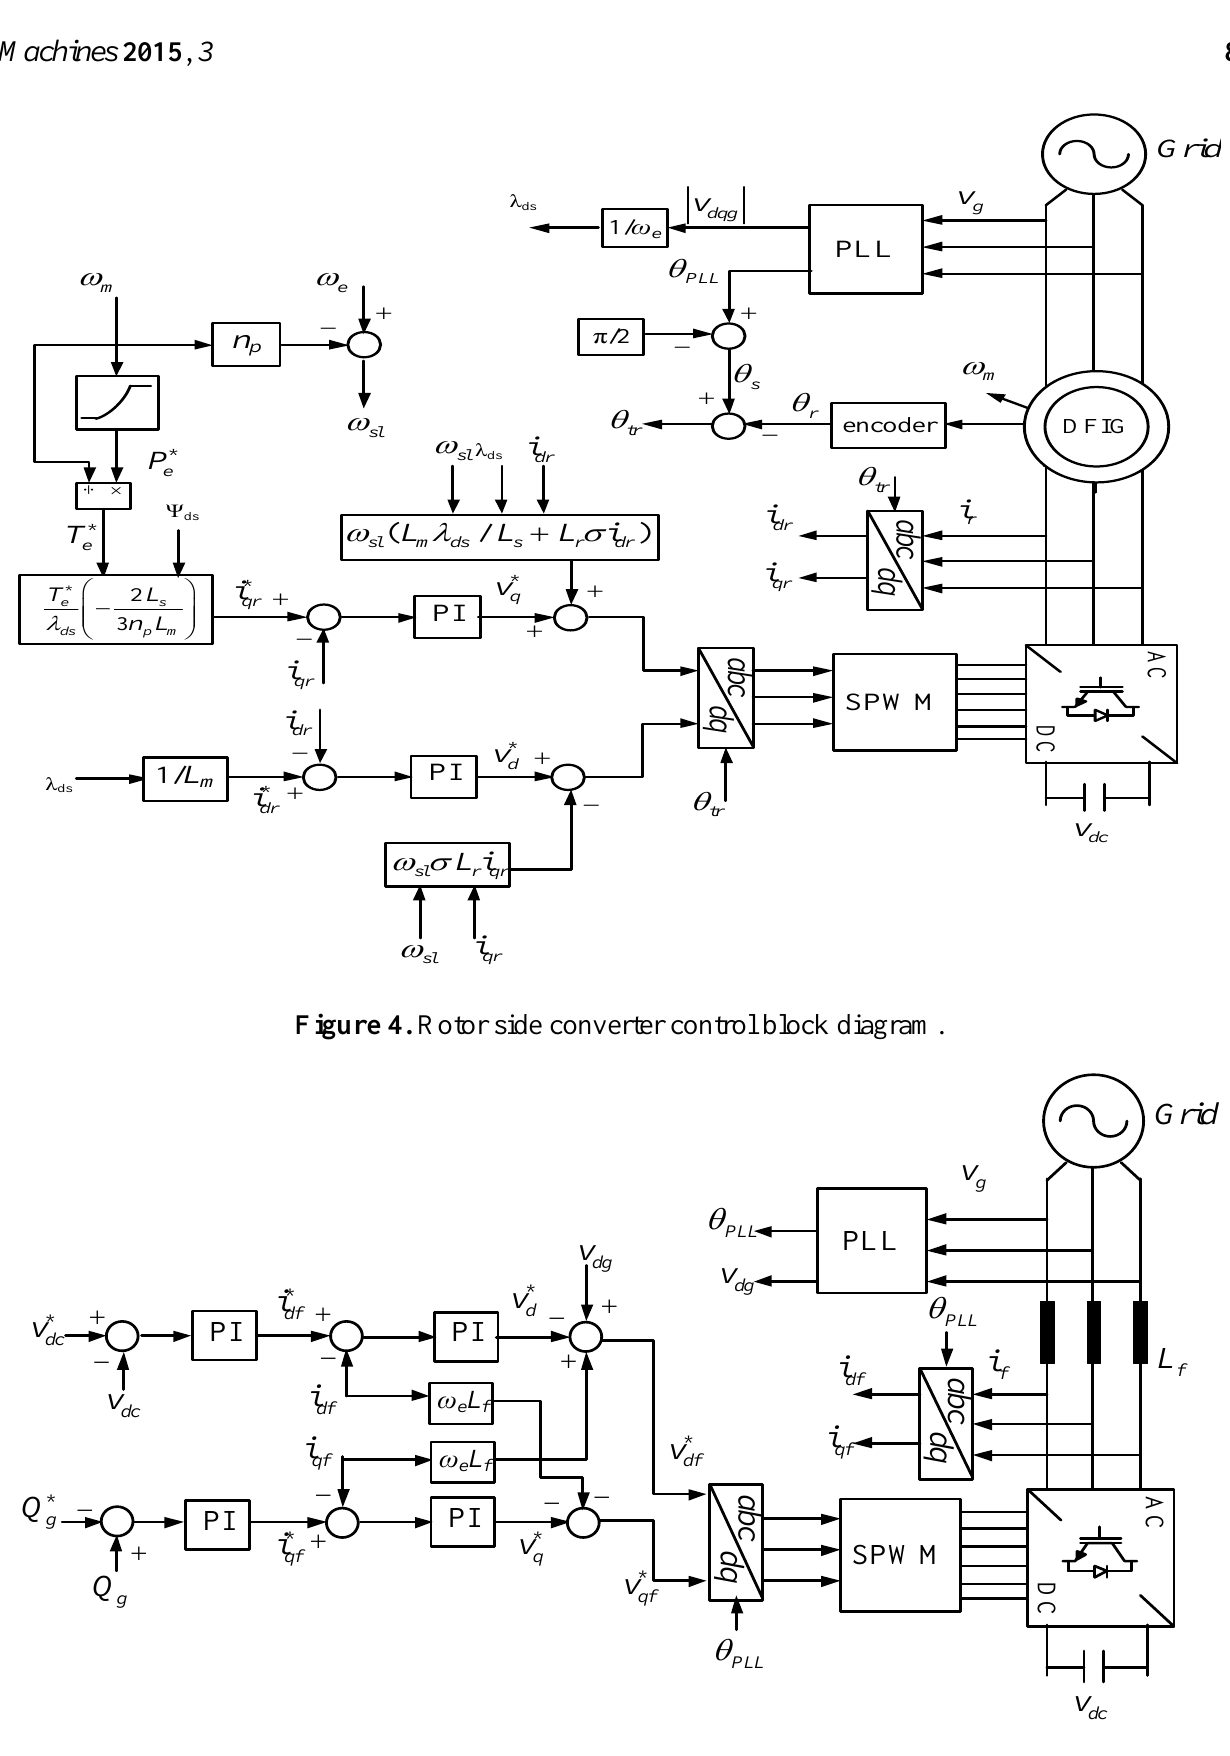
Figure 5. Gird side converter control block